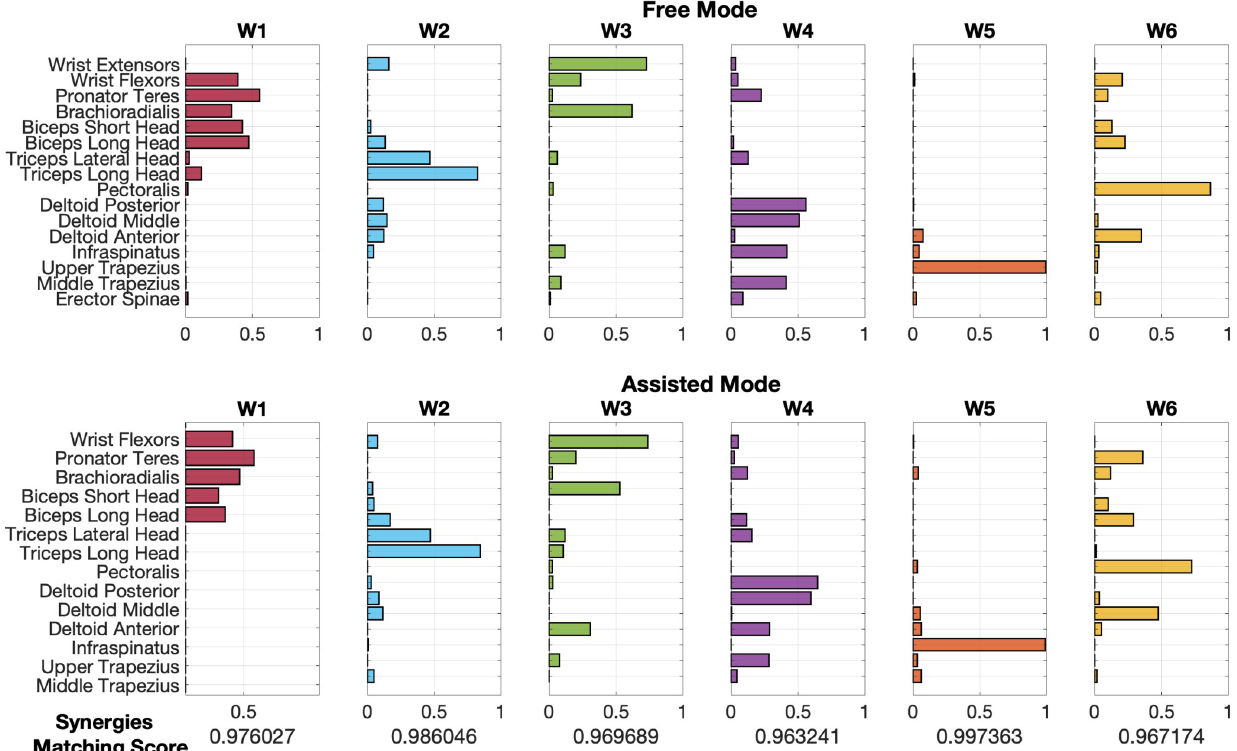
Fig 12. A typical example of paired synergies coupled by similarity following the extraction in the Radial Free and Assisted for the subject 1. We found that the matching score for muscle synergies (W) in the two modes is high: in our trial, assistance influenced task performance, but only a slight modification of muscle synergies was